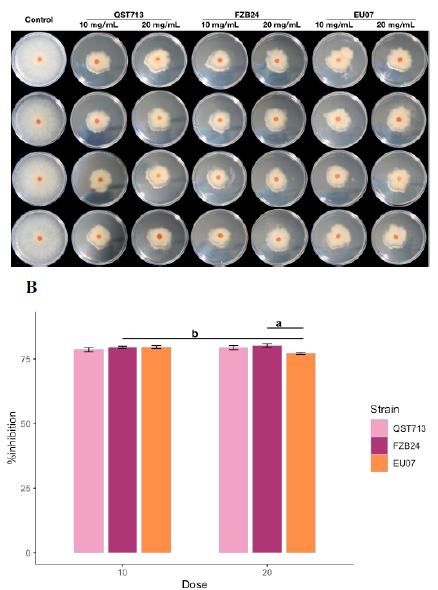
Figure 5. Effect of higher concentration of bacterial broths on Fg -K1-4 growth. ( A ) Antagonism assays on PDA/NA. Bacterial broths were obtained from 24 h bacterial cultures, filtered, adjusted and autoclaved. Bacterial broths are shown by bacterial treatment (top, left to right) and by dosage (top, left to right). High dosages of bacterial broths displayed low fungal growth compared with the control treatment (left column). ( B ) Percentage inhibition of the Fg -K1-4 by the broths of Bacillus strains (24 h), adjusted to 10.0 and 20.0 mg/mL of total protein in the media. Data were from one independent experiment of eight repeats and shown as the mean ± SE. Experiments were replicated twice, and the similar results were obtained. Bars with different letters were significantly different according to Tukey’s Test ( α < 0.05) following two-way ANOVA. n = 48.